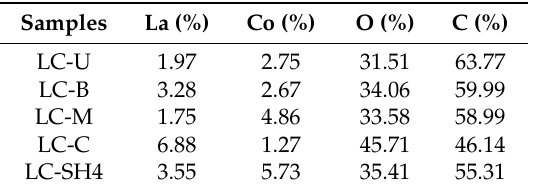
Table 3. Surface atomic concentration of catalysts with different nitrogen